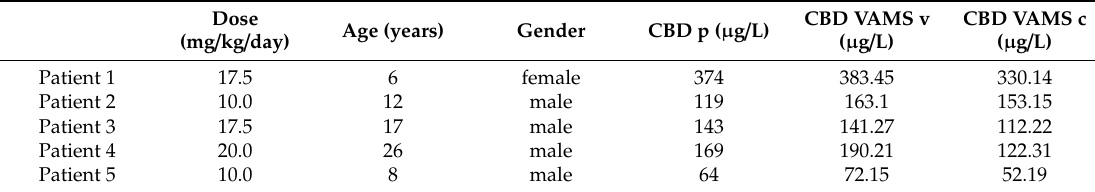
Table 3. Characteristics of patients and results of CBD concentrations (expressed in µ g / L) measured in plasma (p), venous (v) VAMS and capillary (c) VAMS.